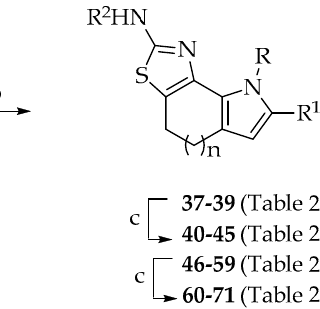
Molecules 2021 , 26 , x FOR PEER REVIEW